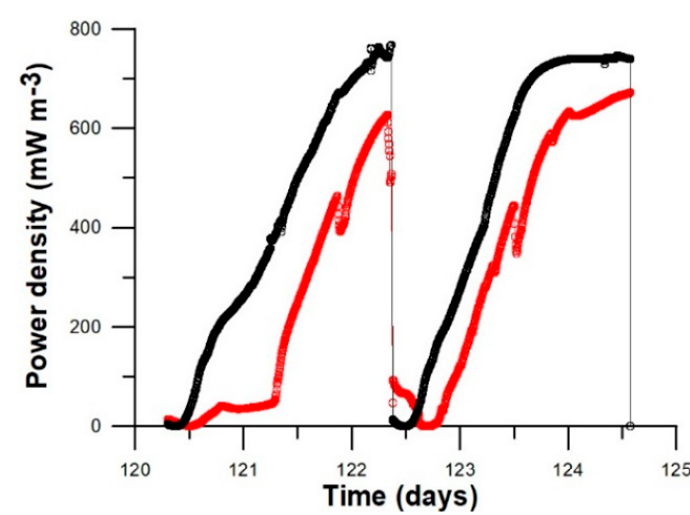
Figure 4. Power density obtained during the last two batch cycles of the third period, during potentiostatic assistance − 150 mV vs. Ag/AgCl. Curves represent duplicate reactors.